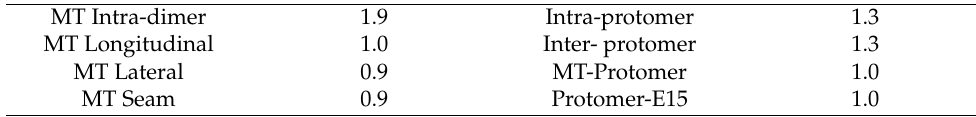
Table 1. (cid:101) h (kcal/mol) values for intra-dimer, longitudinal, lateral and at the seam of the MT lattice, for spastin, and for interactions between spastin and the MT